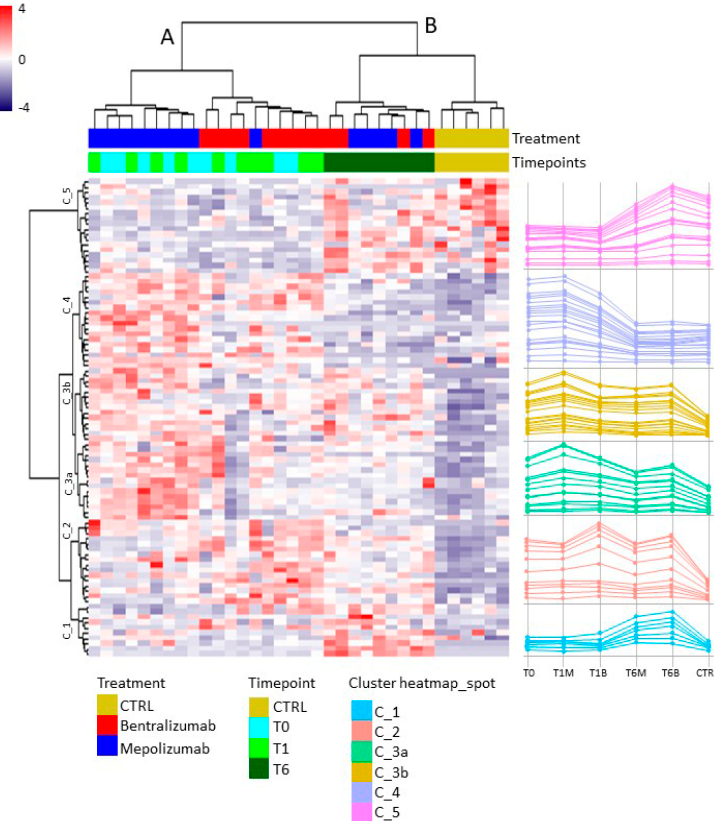
Figure 2. Heatmap analysis performed on significant matched spots in all gels among the six conditions (T0-T1B-T1M-T6M-T6B-CTRL). Blue to red colors in the heatmap graph correspond to protein abundance, as reported by the legend. On the right, the line charts show the trend of abundance of the significant clustered spots .